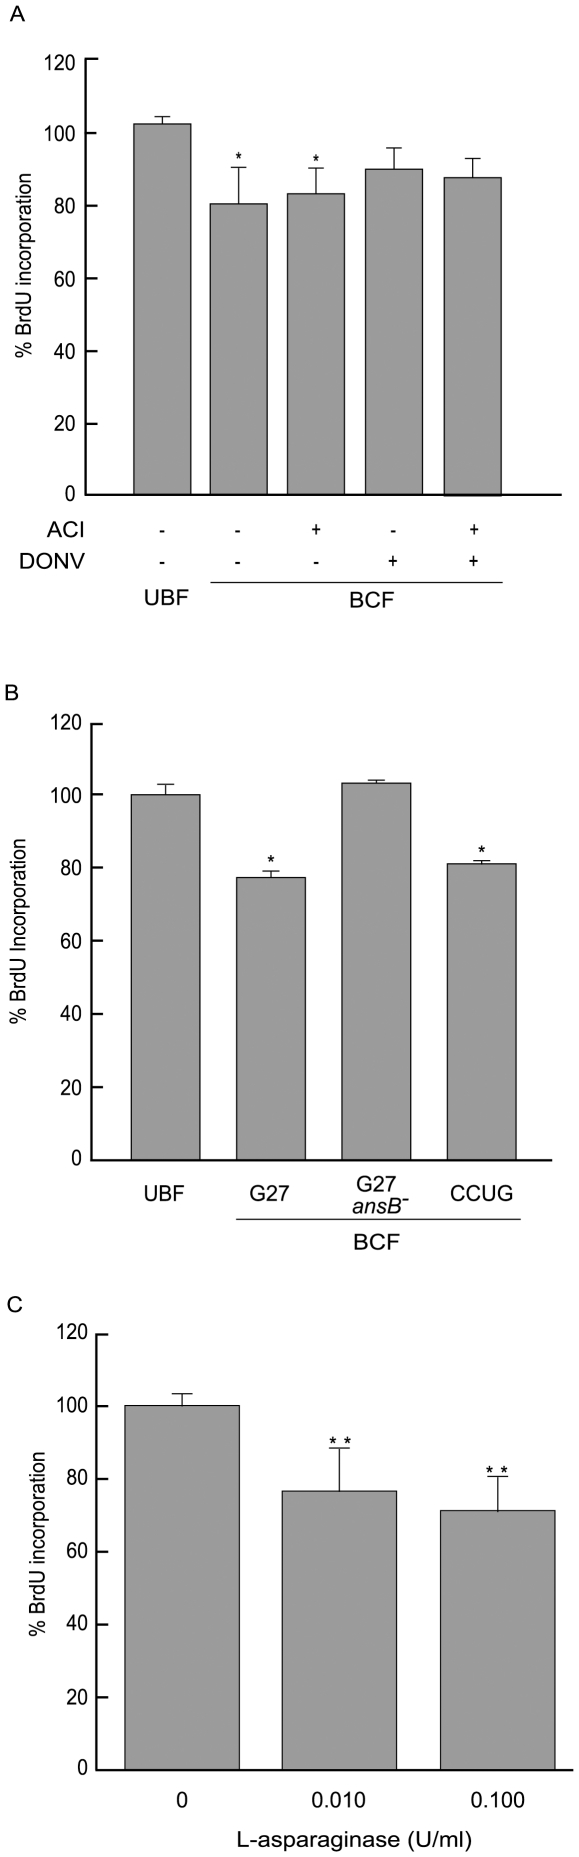
Cell-cycle inhibition in HDF cells.BrdU incorporation in HDF cells incubated with: (A) UBF and BCF treated with the L-asparaginase inhibitor 5-diazo-4-oxo-L-norvaline (DONV, 20 mM) or the GGT inhibitor acivicin (ACI, 5 mM), (B) UBF and BCF derived from different H. pylori strains, (C) different concentrations of recombinant L-asparaginase. Results are expressed as a mean ± SD from 5 independent experiments. *P≤0.05, **P≤0.01.